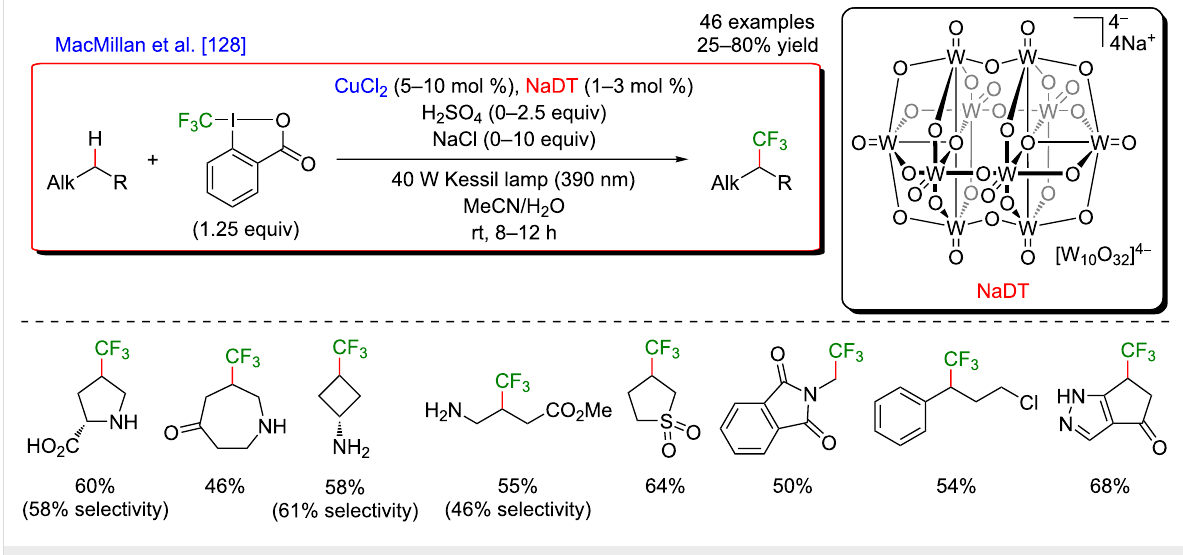
Figure 79: Direct C–H trifluoromethylation of strong aliphatic bonds promoted by HAT.